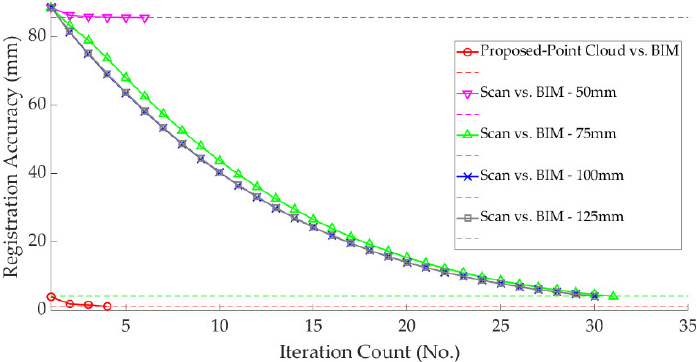
Figure 5. Registration error vs. the iteration number using proposed method of Algorithm 1, compared to the result of scan vs. building information modeling (BIM) [20], with ε Const . = 50 mm, 75 mm, 100 mm and 125 mm.